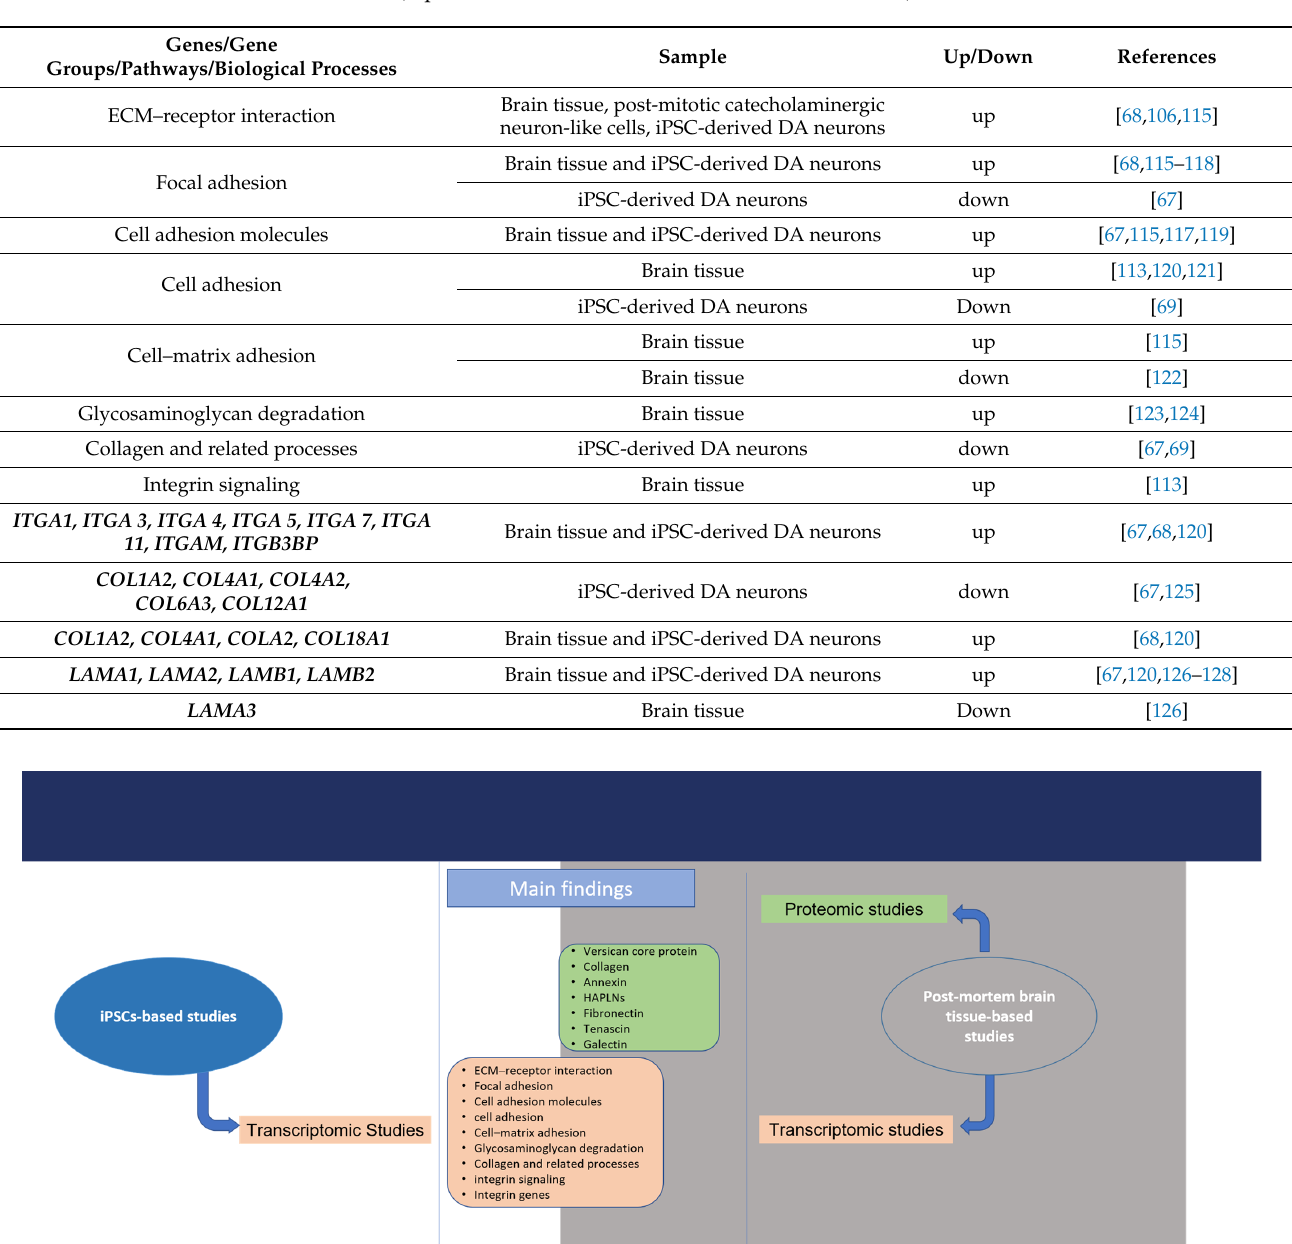
Table 4. Commonly reported differentially expressed ECM-related gene groups/pathways/biological processes from iPSCs and postmortem tissue-based studies of PD patients compared with healthy controls (reported from, at least, two of the included studies).